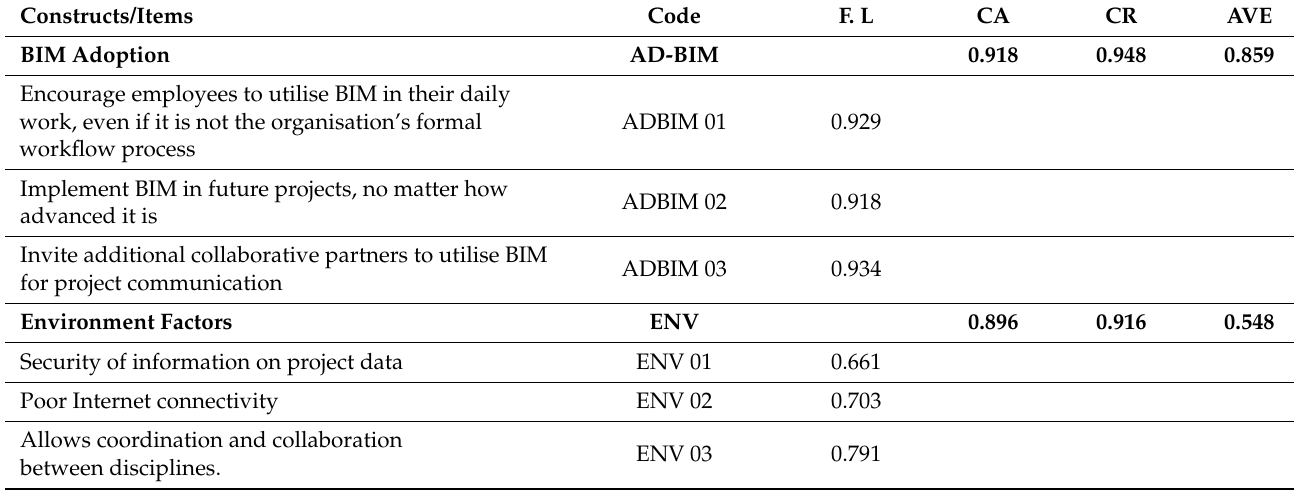
Table 5. Internal Consistency and Convergence Validity